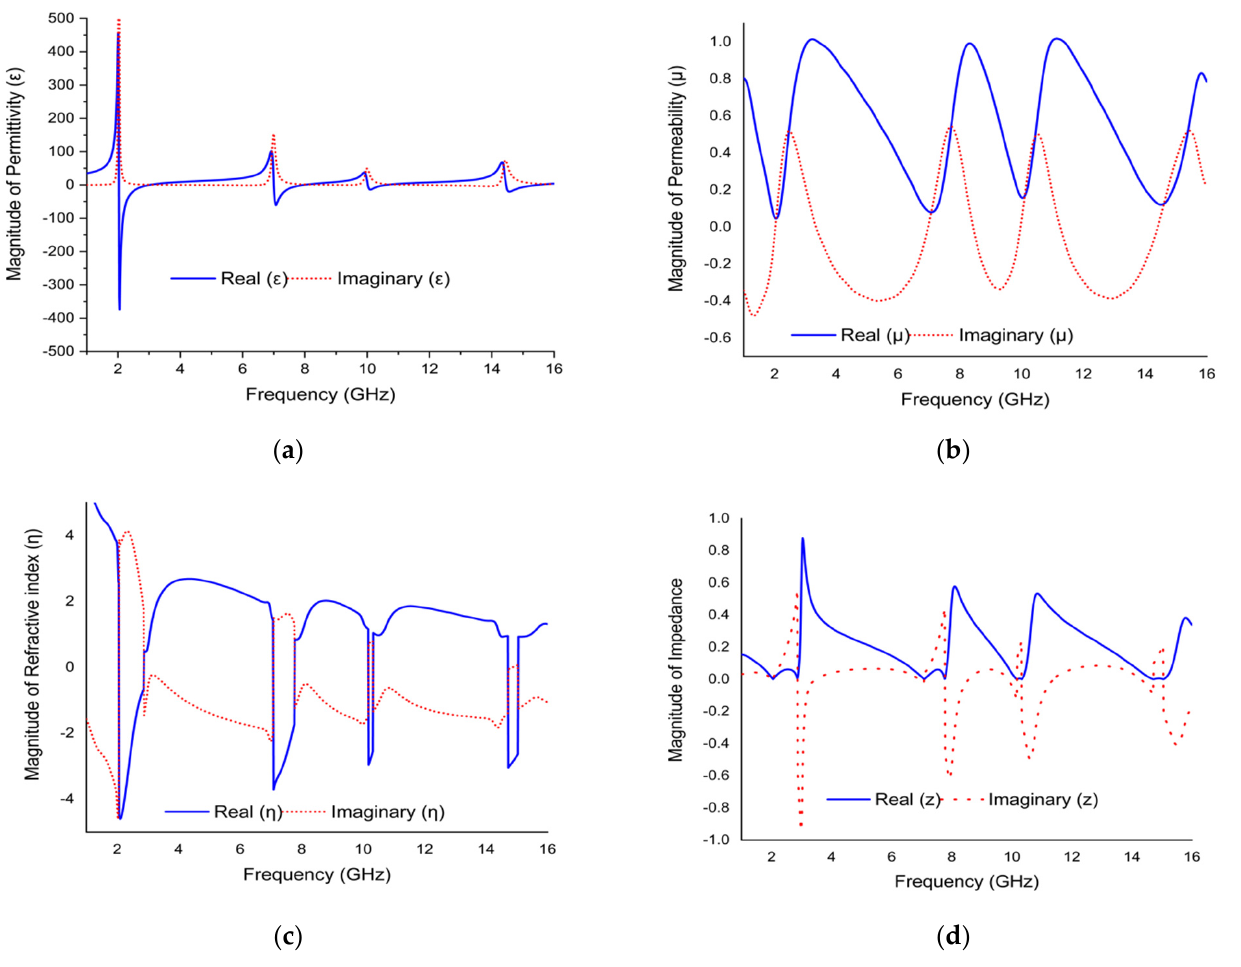
Figure 10. The graph of ( a ) permittivity vs. frequency, ( b ) permeability vs. frequency, ( c ) refractive index vs. frequency, and ( d ) impedance vs. frequency.